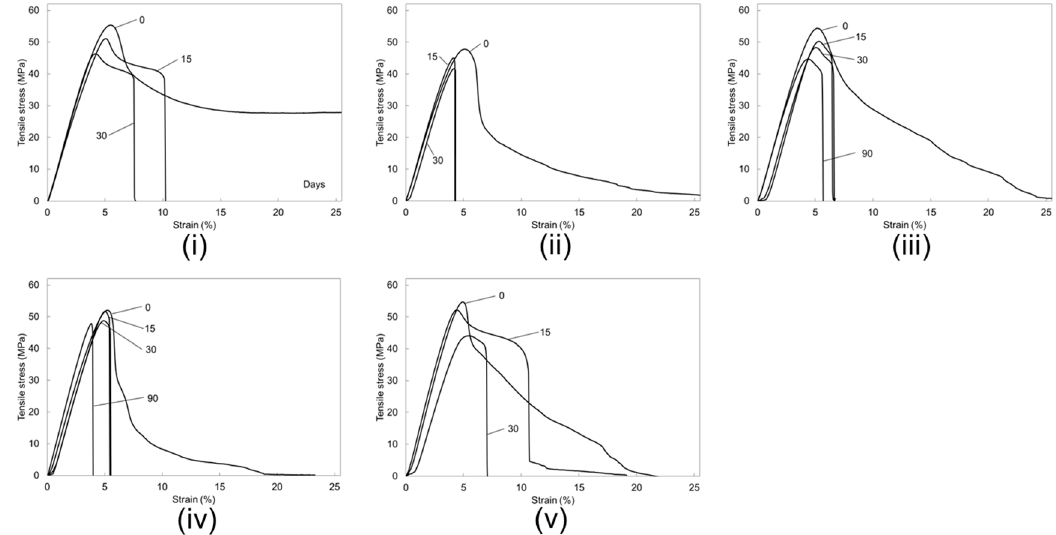
Figure 7. Representative changes of the stress–strain curves in the tensile test after immersion for certain periods. ( i ) P., ( ii ) V., ( iii ) P.V., ( iv ) C., and ( v ) I.M.